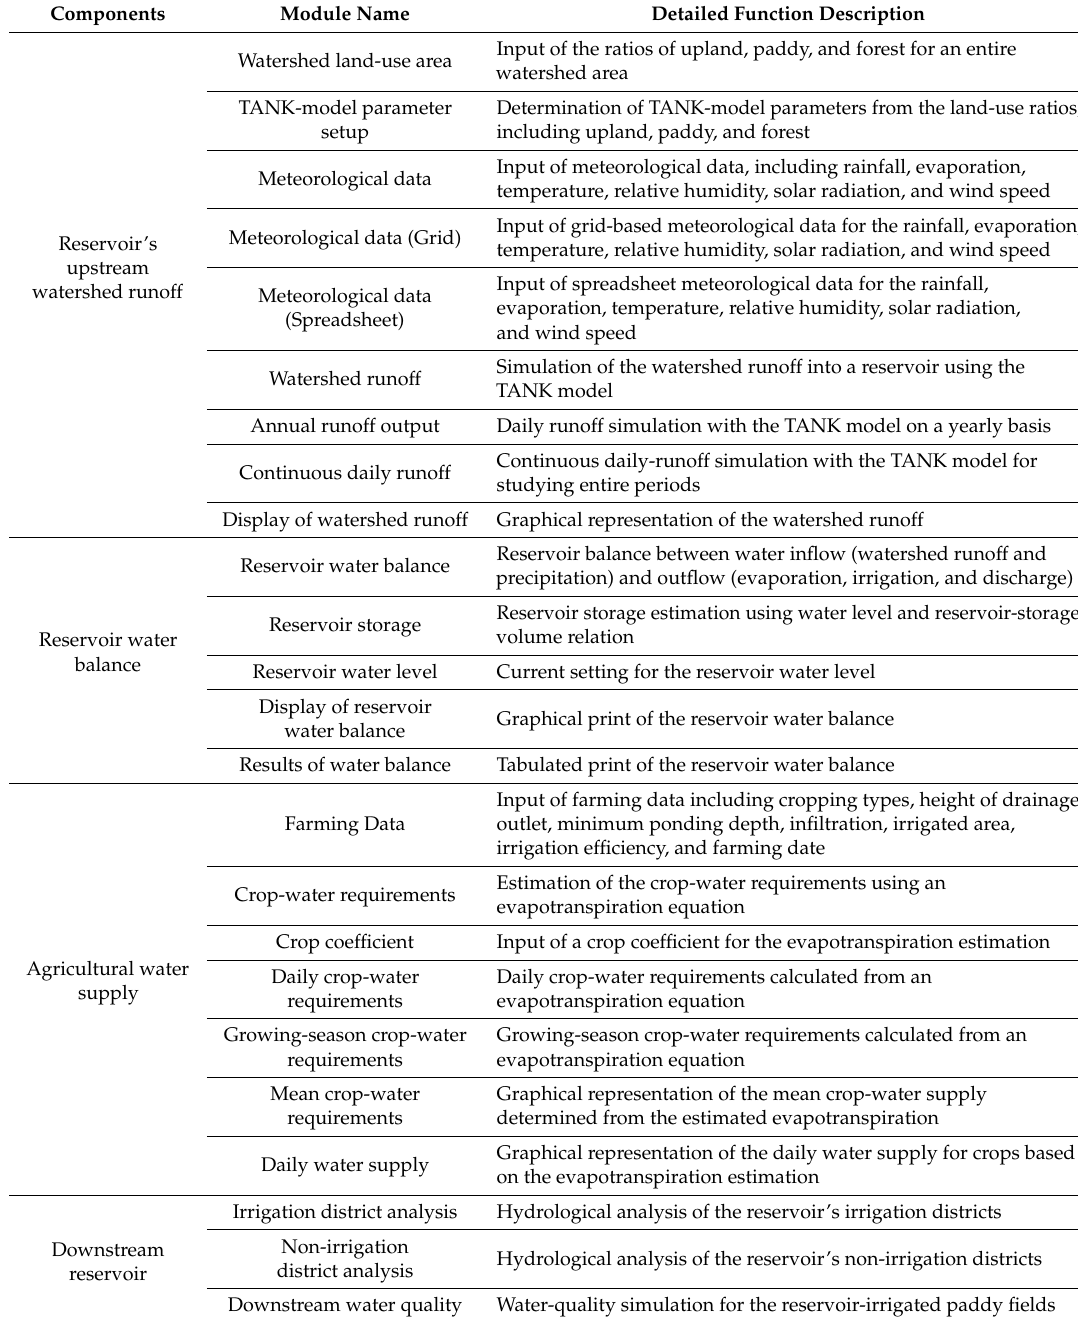
Table 1. Name and function description for basic modules developed in this